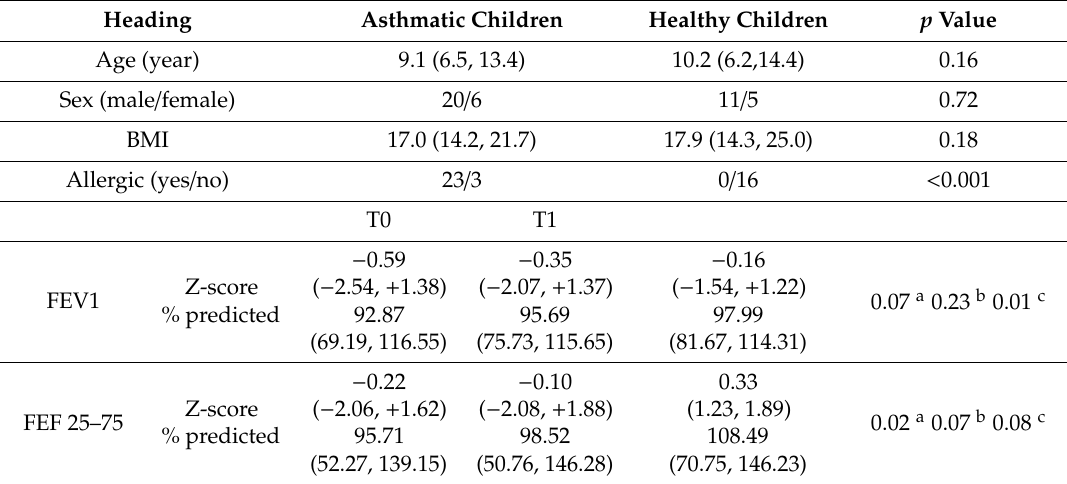
Table 1. Characteristics and spirometric values (expressed as percent of predicted values) of the recruited